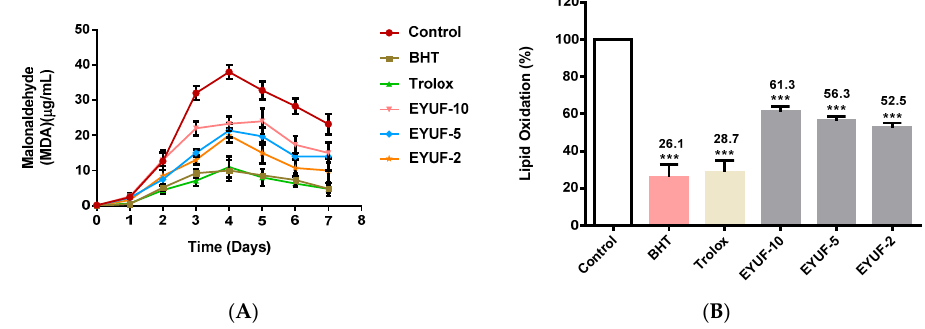
Figure 2. Effect of fractionated egg yolk protein hydrolysates on lipid oxidation by thiobarbituric reactive substance (TBARS) method. ( A ) Malondialdehyde concentration was monitored every 24 h for 7 days at 532 nm; ( B ) Percentage of lipid oxidation, indicated at the top of the bar, was measured after four days incubation at 40 °C. BHT and trolox (0.2 mg/mL of each), shown in colour, were used as positive controls, while milli-Q water was used in the negative control instead of sample. EYUF-10, EYUF-5 and EYUF-2 are fractions collected after passing through 10, 5, and 2 kDa ultrafiltration membranes (50 mg/mL of each fraction). Data correspond to the means ± SD of three independent experiments. ANOVA was performed in Graphpad Prism version 6.0, followed by Dunnett’s multiple comparisons test. The result was considered statistically significant versus the water control ( *** = p < 0.001).